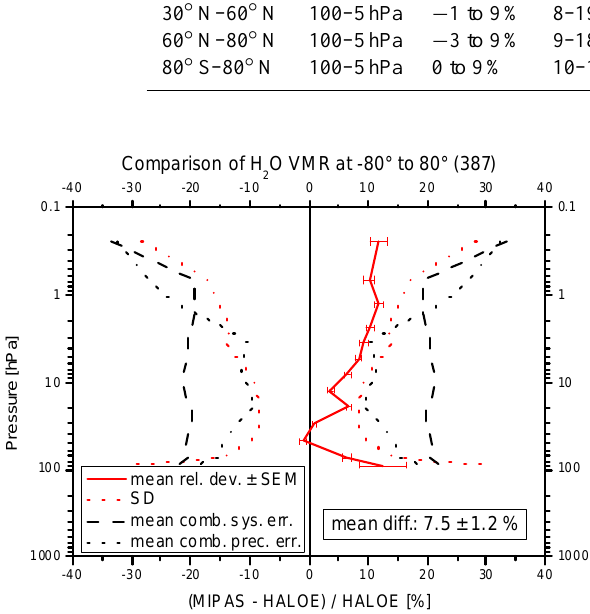
Fig. 14. Mean relative deviation of H 2 O profiles as measured by MIPAS and HALOE for all collocations (387) between 80° S and 80° N. Annotation as per Fig. 13.